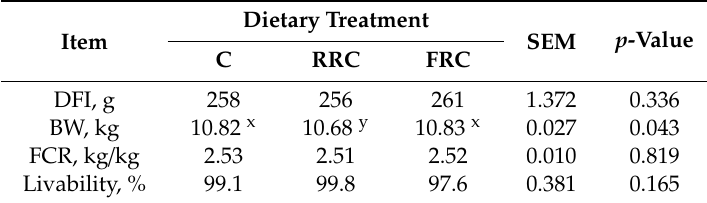
Table 3. Growth performance of turkeys fed a control diet (C) and diets containing raw rapeseed cake (RRC) or fermented rapeseed cake